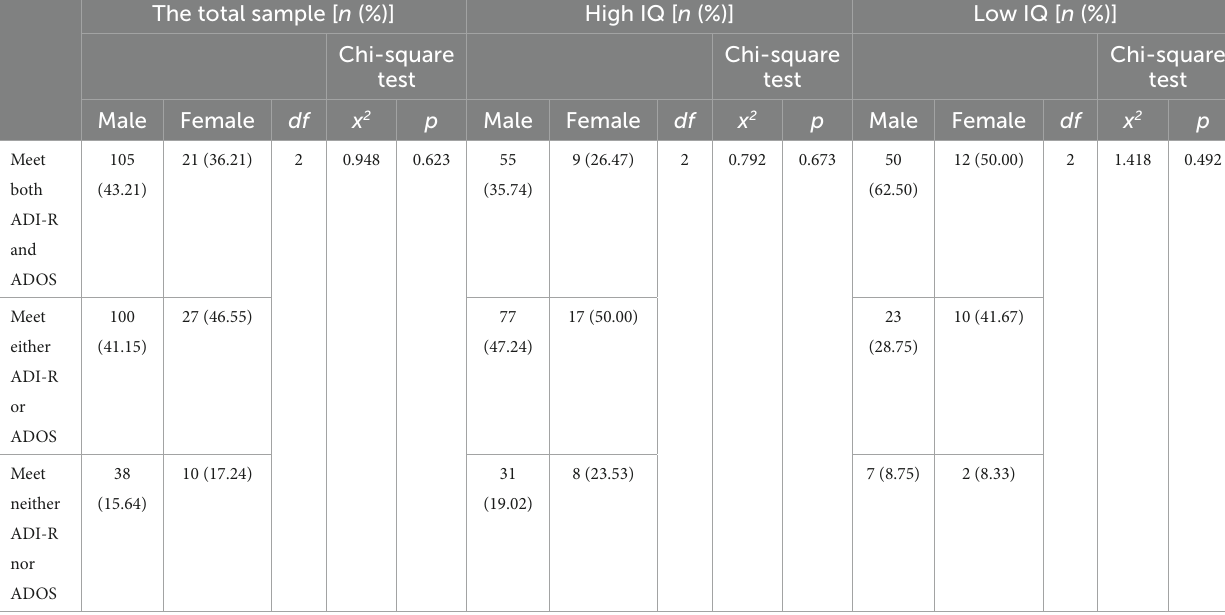
TABLE 5 Autism diagnosis compliance rate in both ADI-R and ADOS assessment.